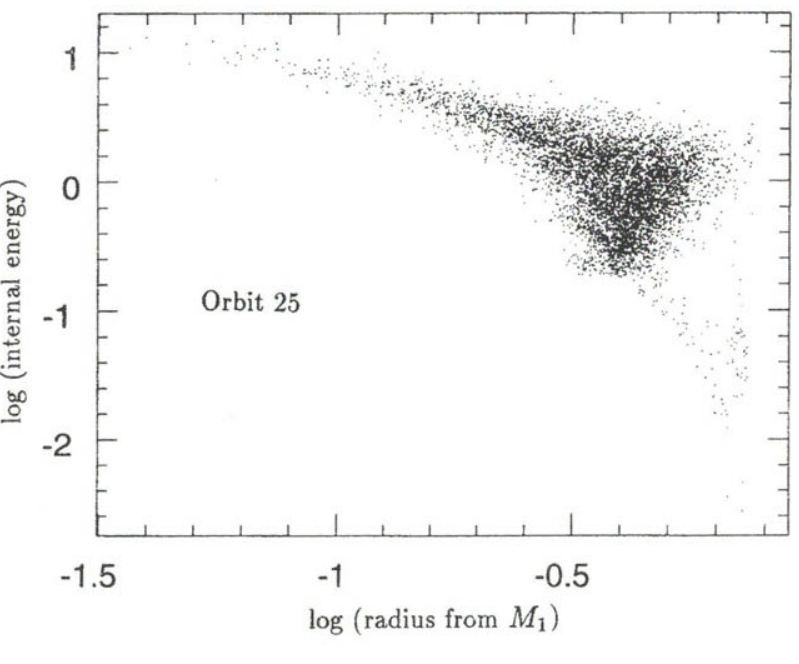
Fig. 3. The logarithm of the dimensionless internal energy as a func- tion of distance from